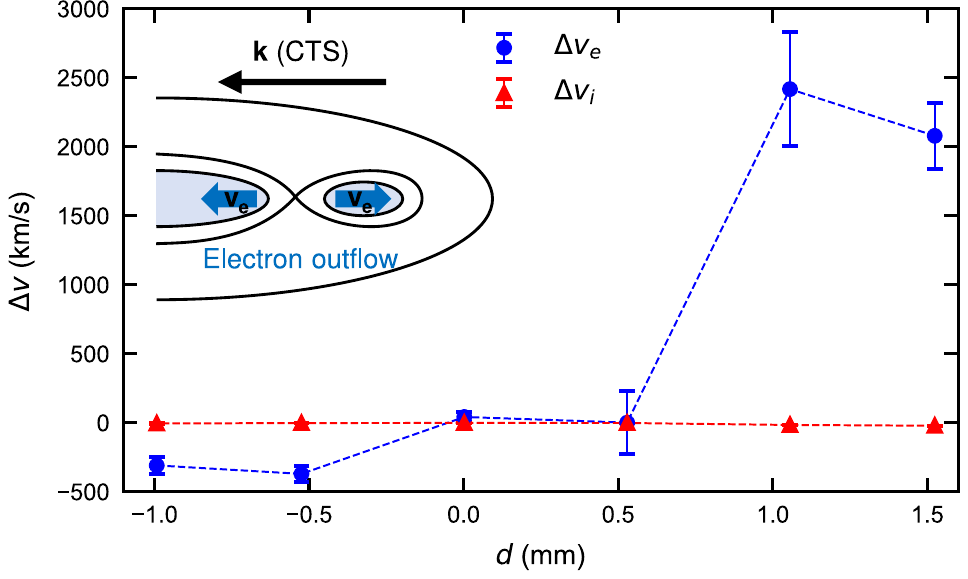
Figure 3. Velocity difference with and without applied magnetic field. We define (cid:31) v e , i ≡ v B e , i − v noB e , i , where v B e , i is the velocity with the applied magnetic field and v noB e , i is without for electrons and ions, respectively. The blue and red markers are (cid:31) v e , i for electron and ion, respectively. The marked spatial change of (cid:31) v e is consistent with the electron outflow resulting from electron-scale magnetic reconnection as shown in the